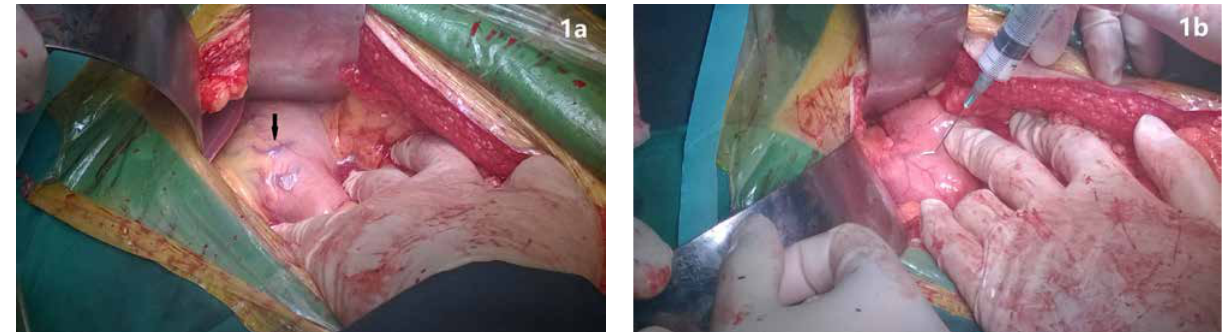
Figure 1: Varicose veins before and after foam injection. a) Varicose veins at lesser gastric curvature (arrow). b) Occlusion of varicose veins after injection of Polidocanol